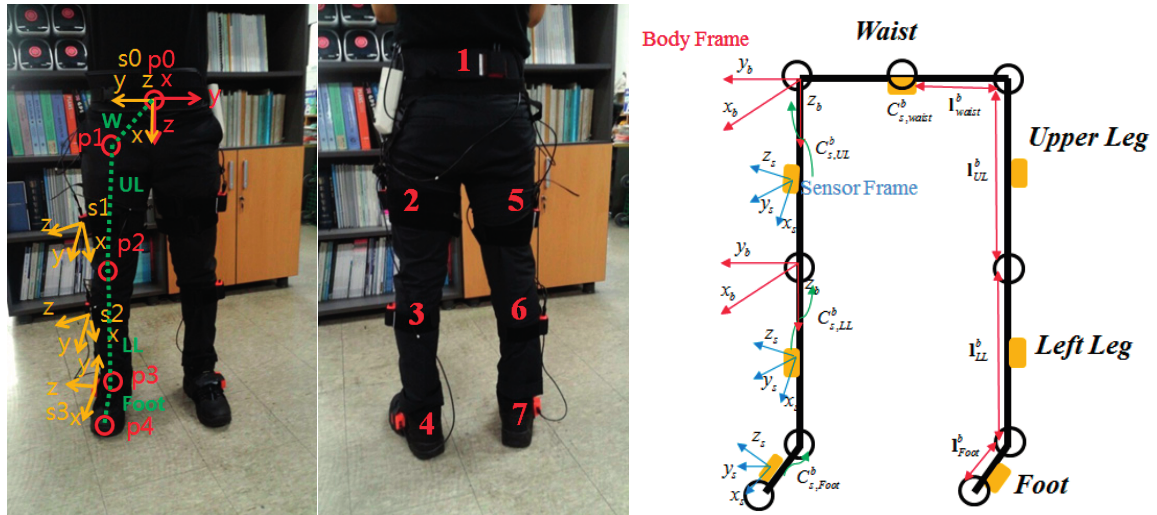
Figure 1. Location of attached sensors and kinematic